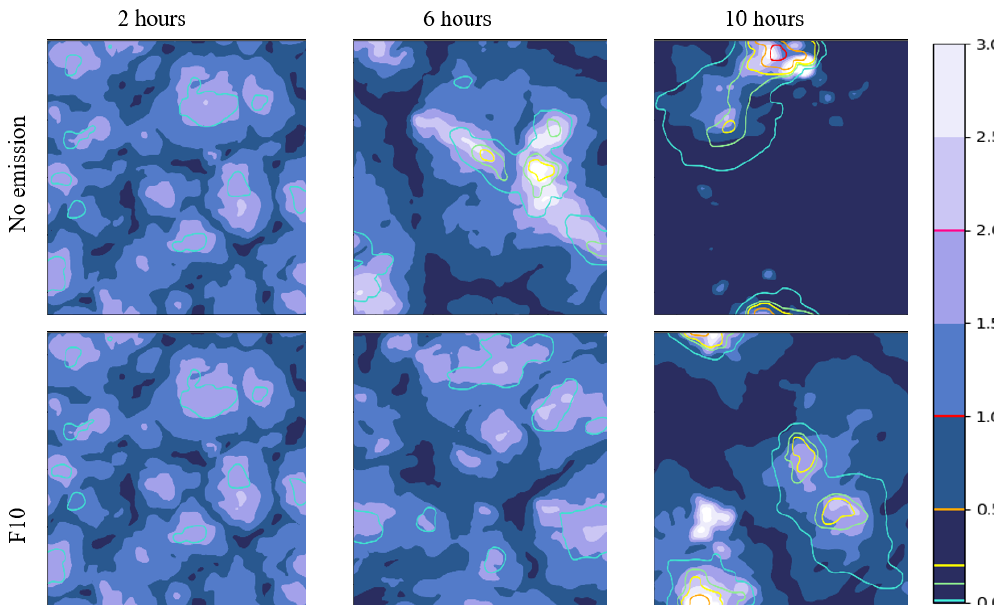
Figure 2. Development of the cloud layer and drizzle in the 10 × 10km model domain 2, 6, and 10h after the simulation start in the no-sea- spray (upper row) and F10 case (lower row) simulations. Contours – surface precipitation rate (mmh − 1 ), white shading – liquid water path (gm − 2 ) (scaled by a factor of 0.01 to fit on the same scale as precipitation).